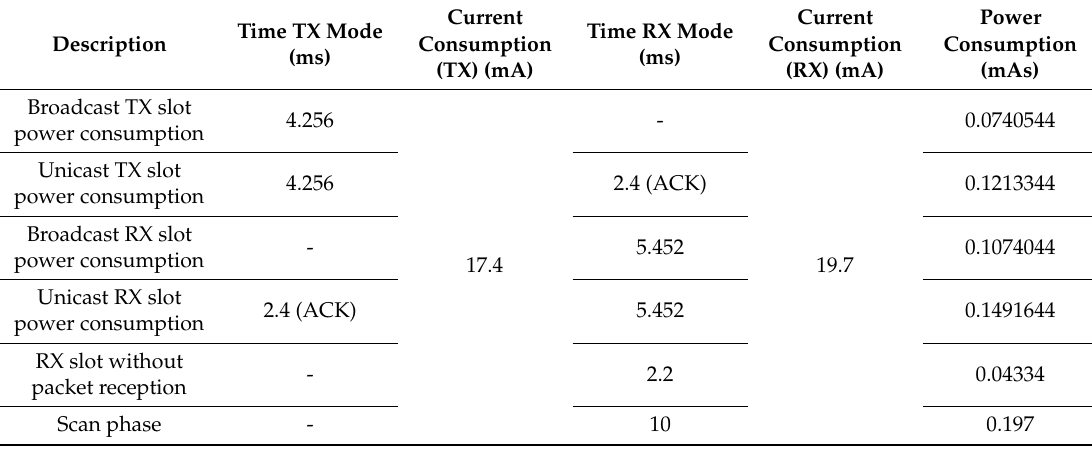
Table 6. Power consumption for the different slot types.